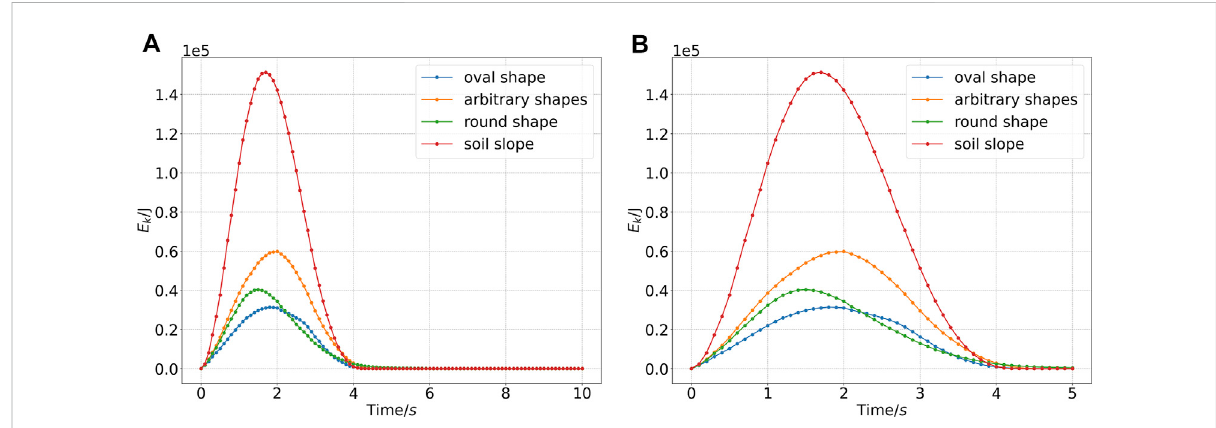
FIGURE 4 Kinetic energy curve. (A) Kinetic energy curve during simulation. (B) 0 ~ 5s apparent kinetic energy